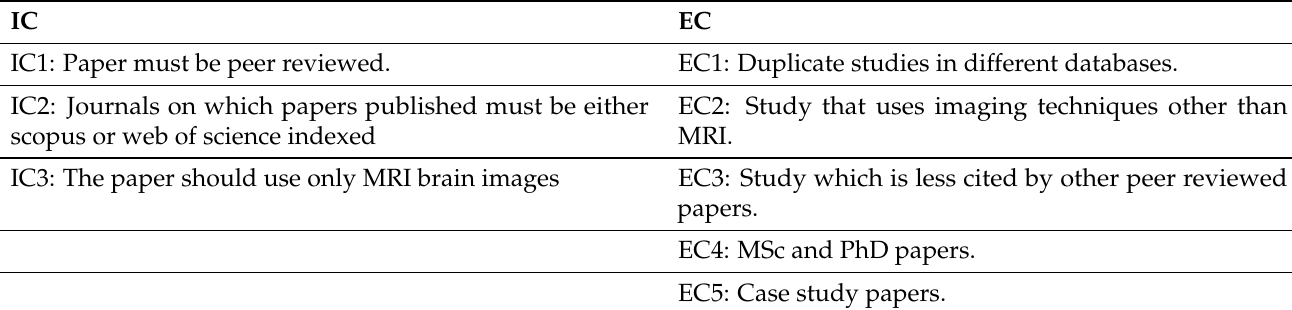
Table 2. Inclusion and exclusion criteria for paper